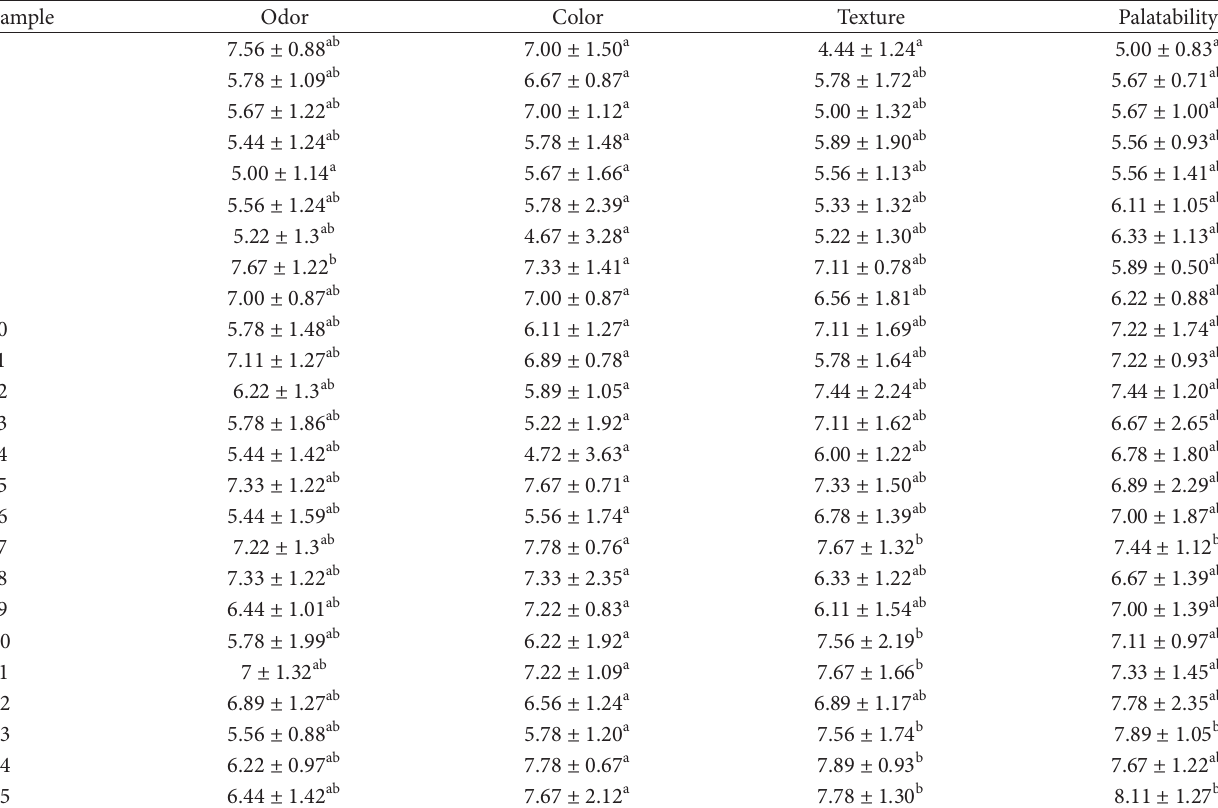
Table 3: Sensory results of all the fried fritters samples.